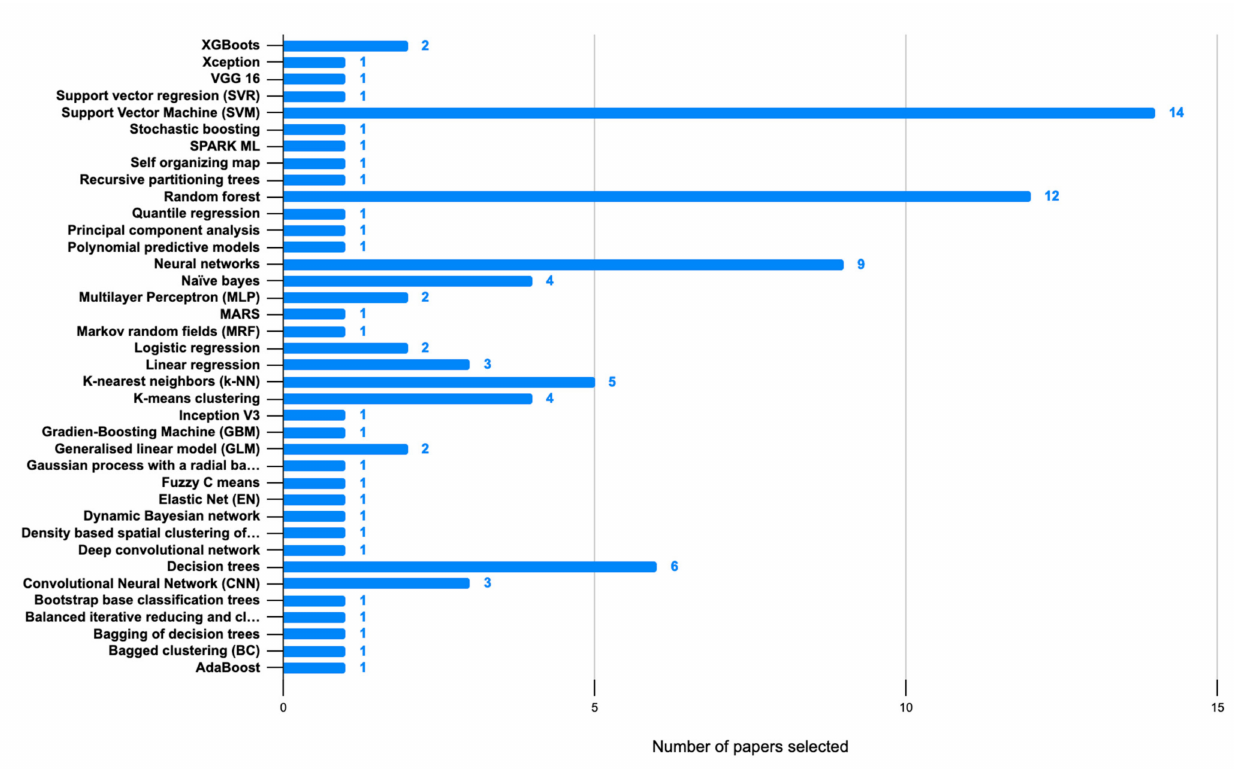
Figure 16. ML Techniques used in Big Data for